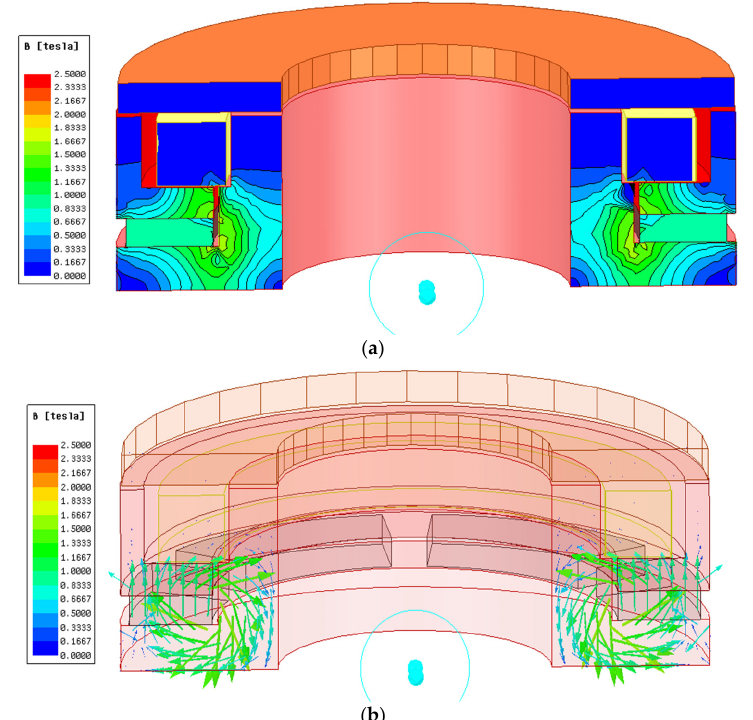
Figure 8. Magnetic flux distribution when energized. ( a ) Magnetic flux density cloud image. ( b ) Magnetic flux vector distribution diagram.